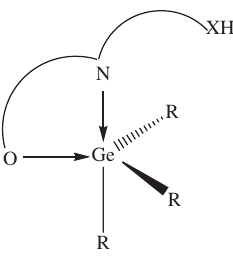
Figure 1 Structure of the complexes . HO ∩ N ∩ XH is the donor set of the ligands, X = O or S and R = Me or Ph